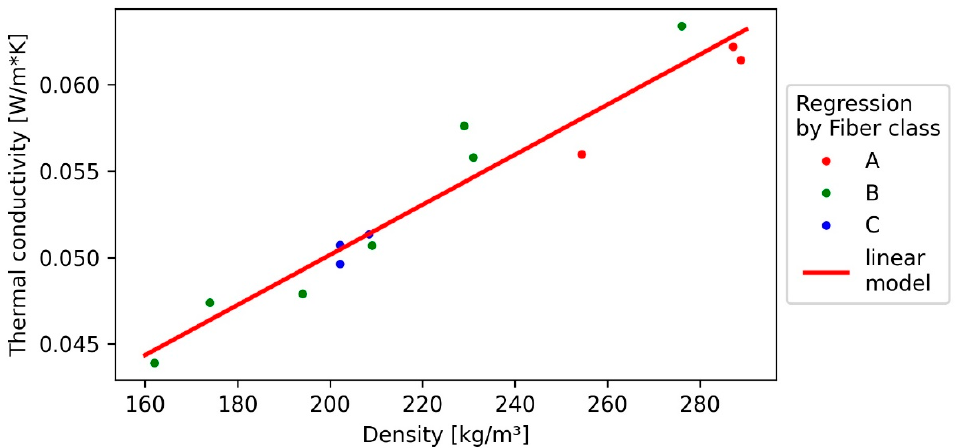
Figure 8. Simple linear regression (SLR) of thermal conductivity towards density (line) and measured values (points).